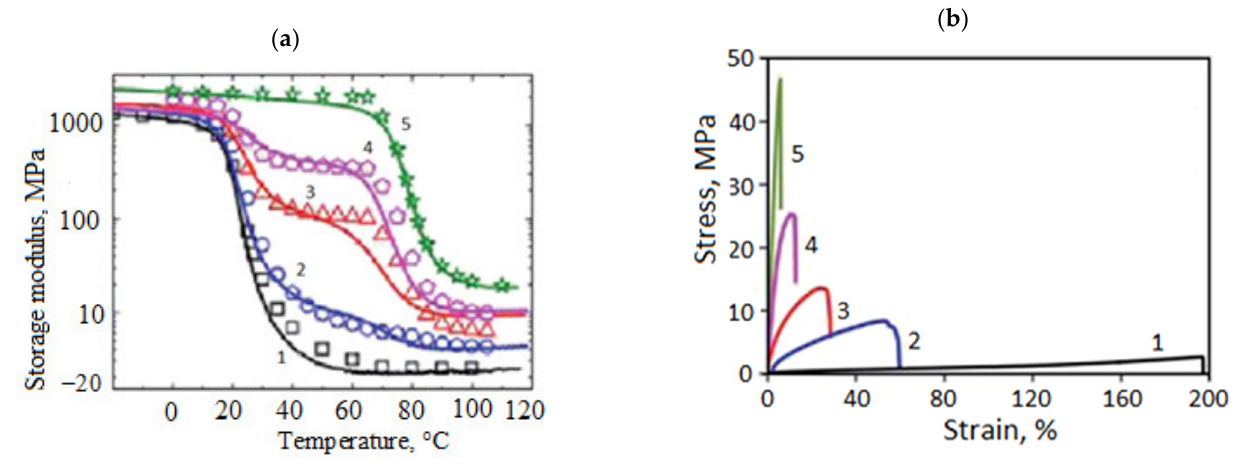
Figure 5. Data on the mechanical properties of the formed vitrimers: ( a ) curves of the temperature dependence of the Young’s modulus (lines show the experimental results, dots show the calculated ones); ( b ) stress-strain curves. (1) A soft component of the vitrimer blend; (2) Soft:Hard = 7:3; (3) Soft:Hard = 5:5; (4) Soft:Hard = 3:71; (5) a hard component of the vitrimer blend. Reproduced from Ref. [93] with permission from the Royal Society of Chemistry.